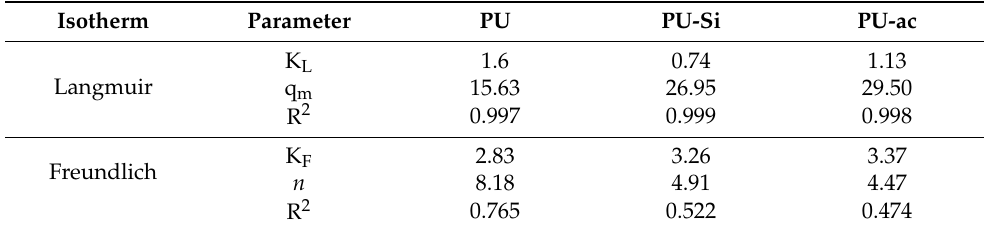
Table 2. Isotherm parameters for diesel adsorption.